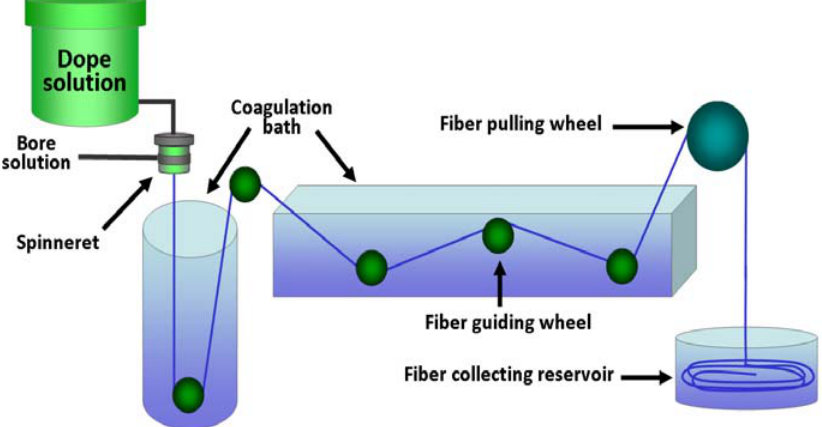
Figure 13. Illustration of a hollow fiber membrane spinning setup. The dope solution emerges from the spinneret into the coagulation baths and is collected in a